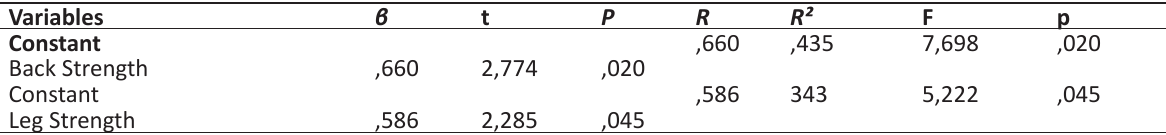
Table 4. Regression analysis regarding the prediction in serve throwing speed in tennis